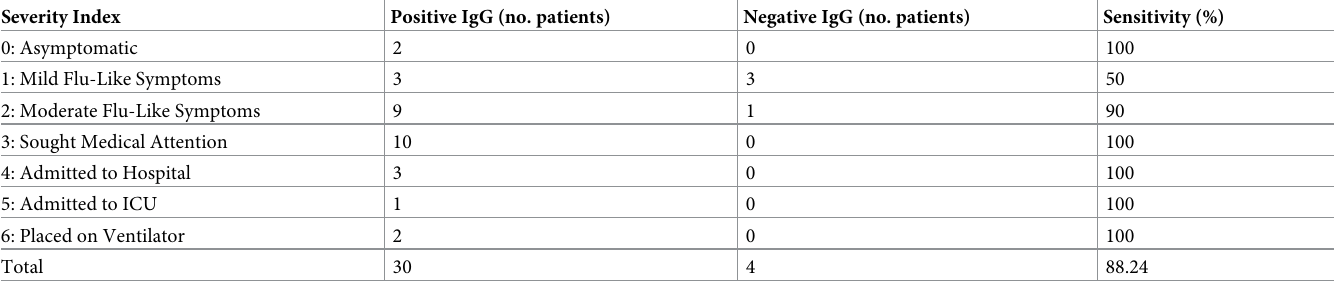
Table 1. Correlation of Amperial ™ anti-SARS-CoV-2 IgG levels in saliva with severity of symptoms in 34 COVID positive subjects. Severity Index